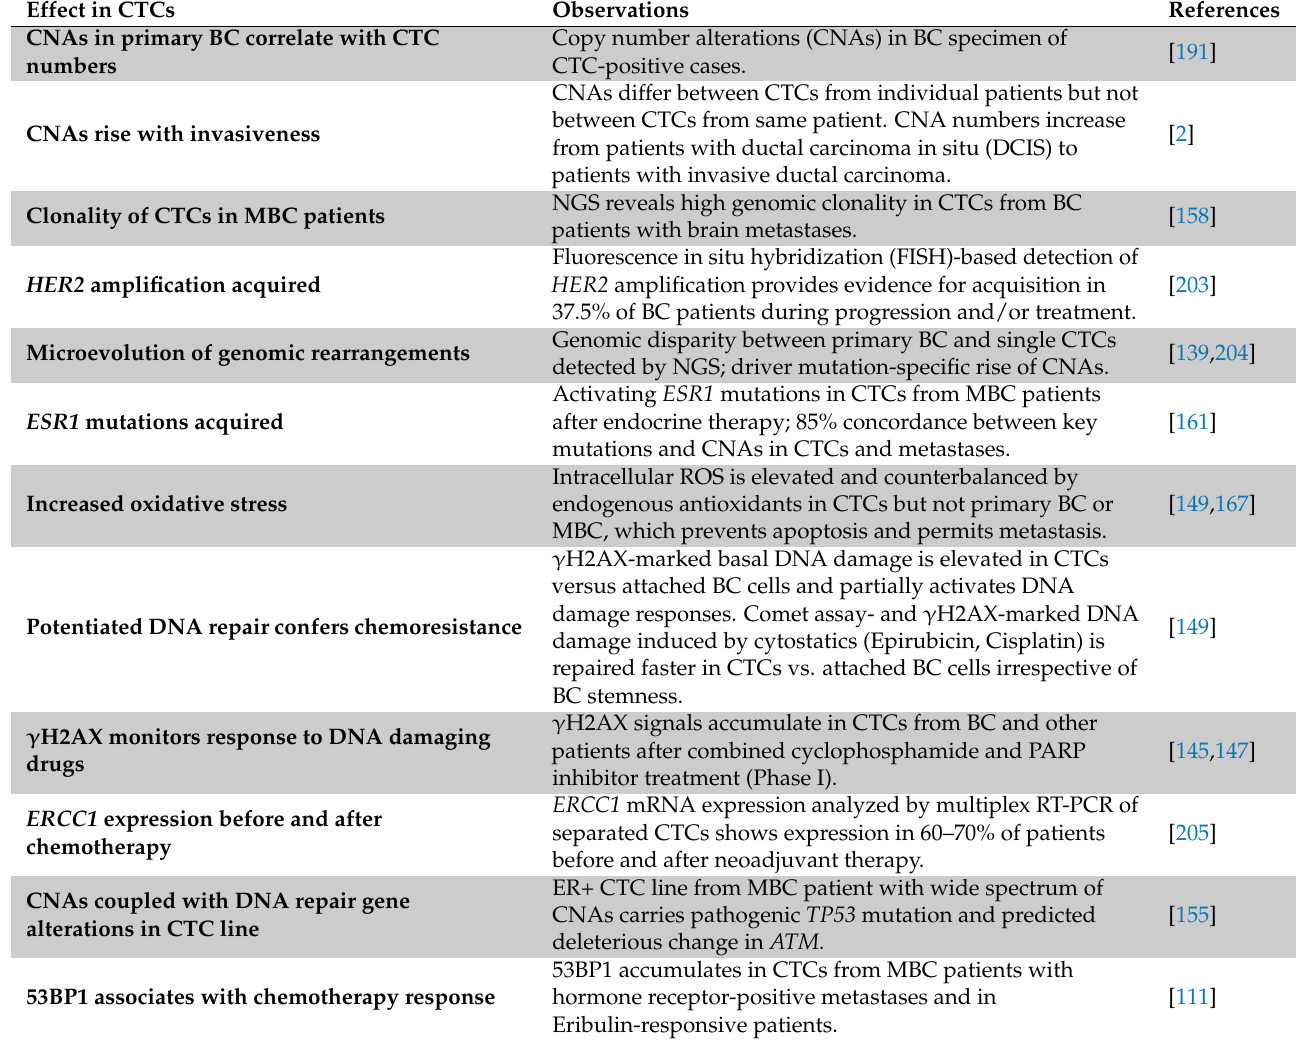
Table 2. Genomic instability and DNA damage responses in CTCs from BC